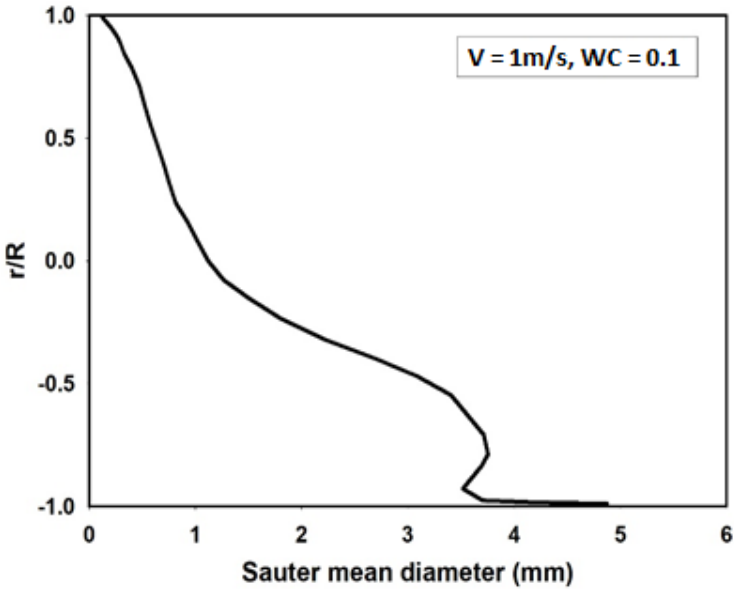
Figure 14. Vertical distribution of Sauter mean diameter across pipe section for test 4 (V = 1 m/s, water cut = 0.1).